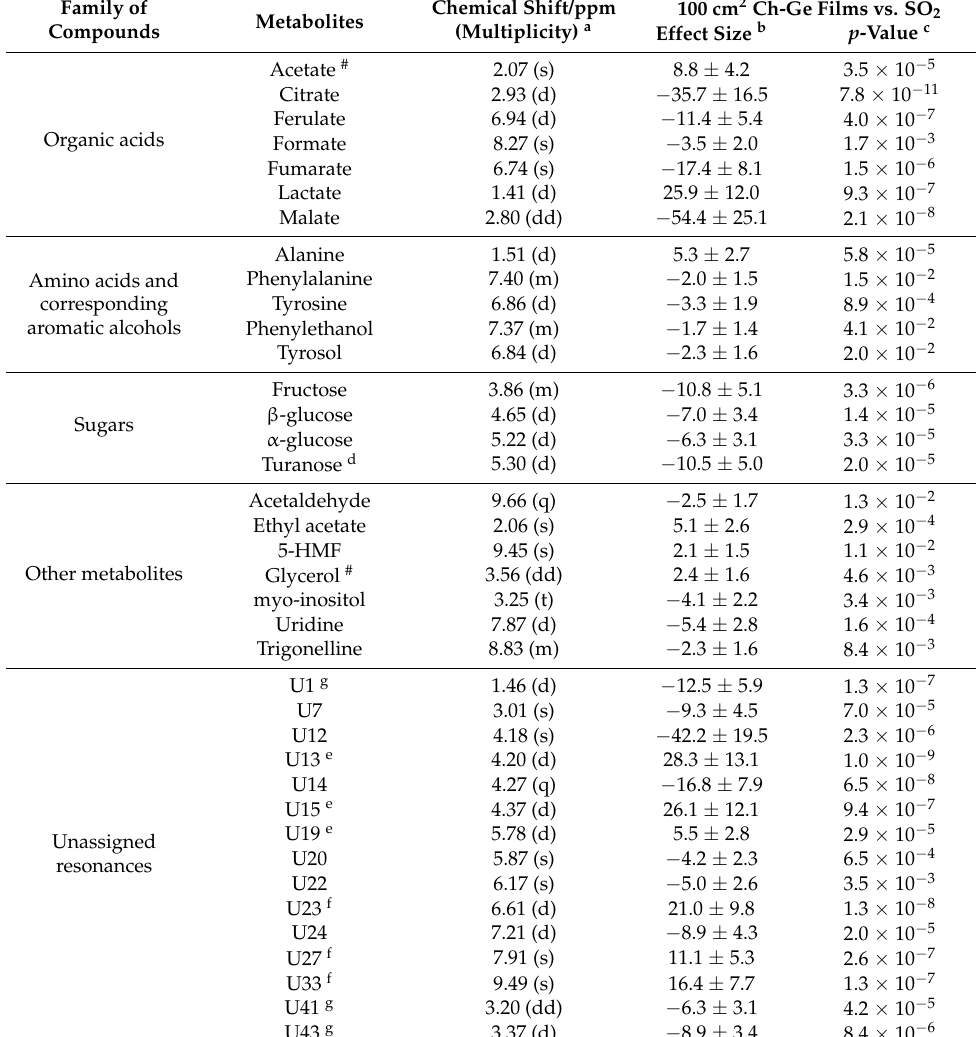
Symbols and abbreviations: s, singlet; d, doublet; dd, doublet of doublets; t, triplet; q, quartet; m, multiplet; 5-HMF, 5-hydroxymethyl furfural; Ui, unassigned resonance